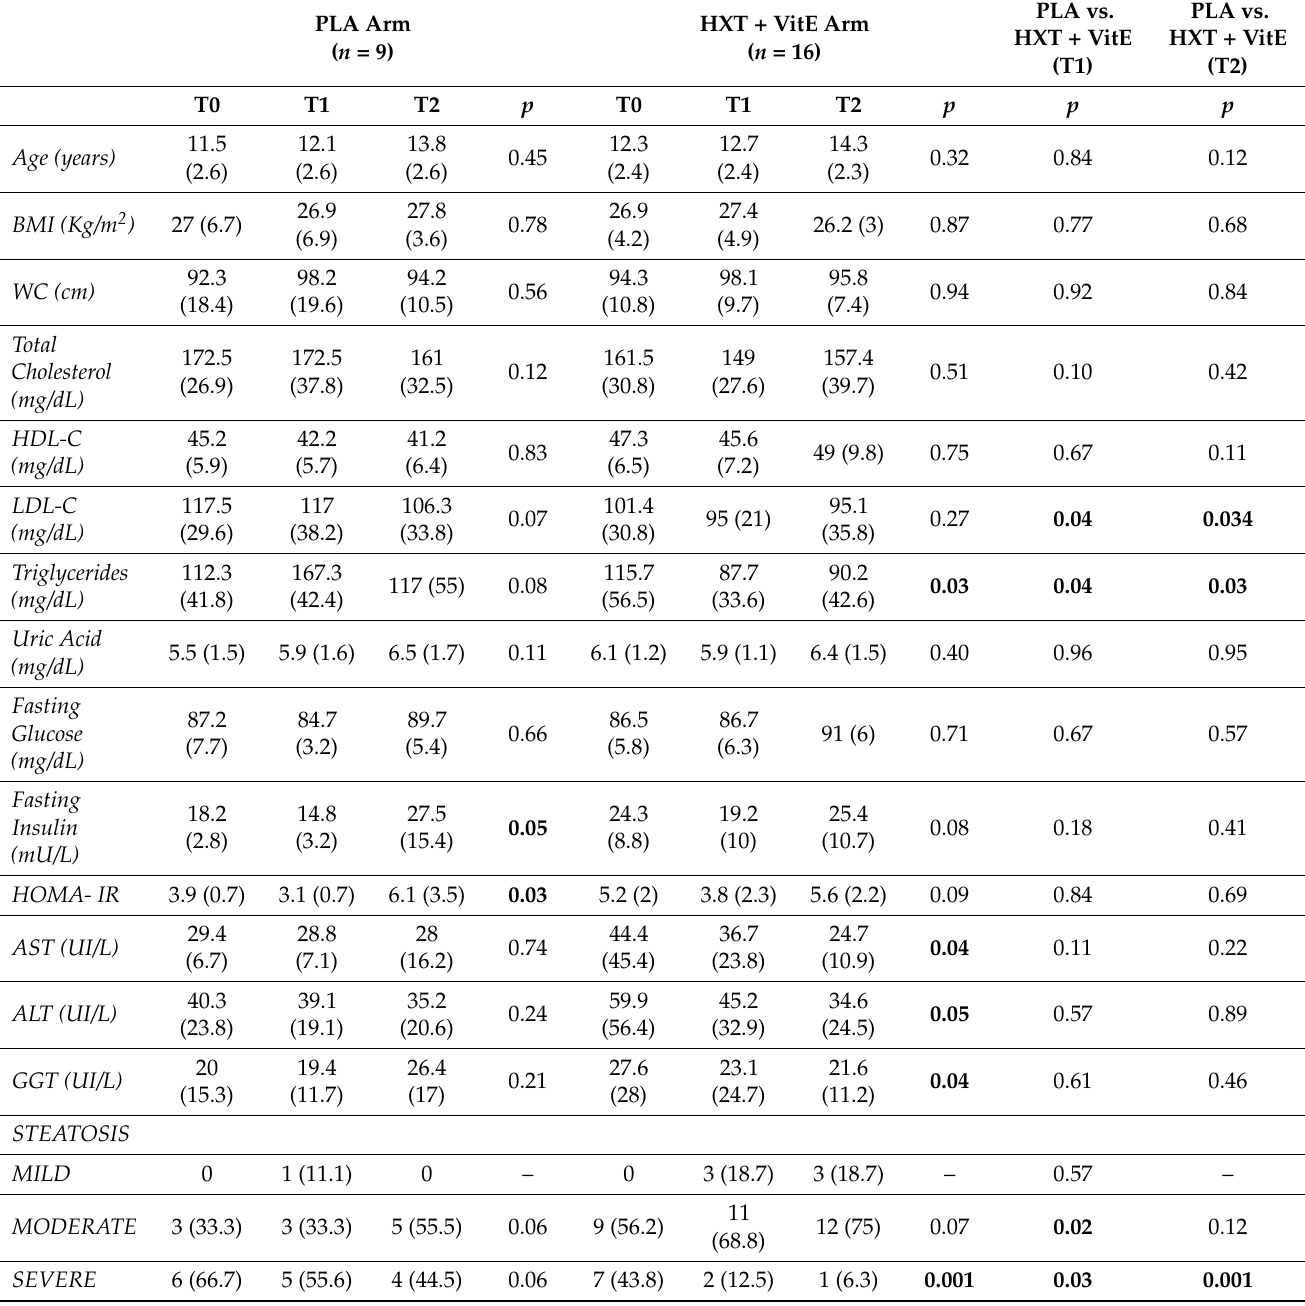
Table 1. Patients’